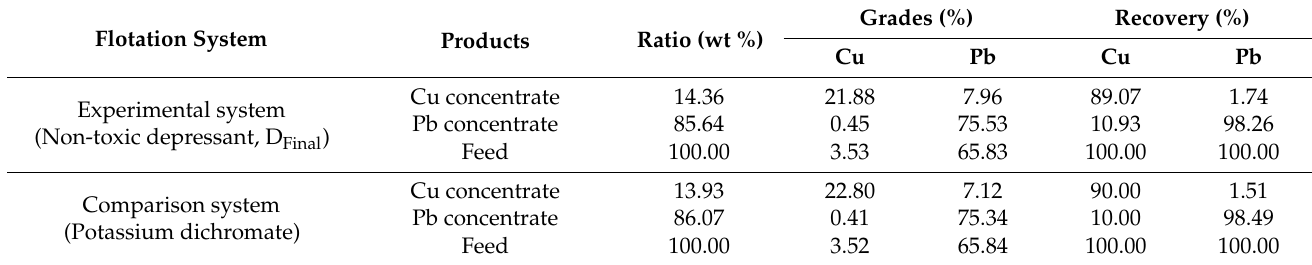
Table 5. Results of the batch locked-cycle